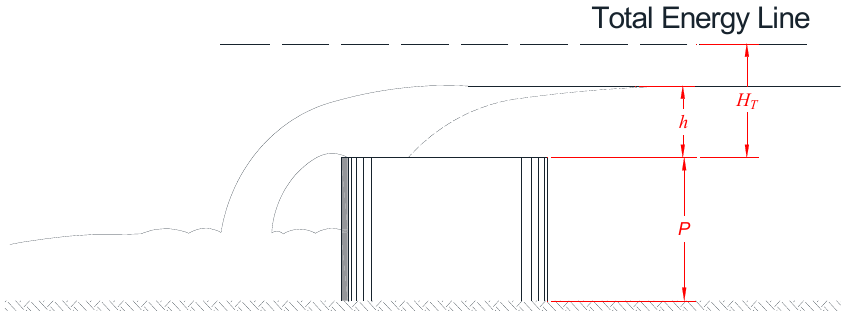
* The effective length (centerline length) of the weir.